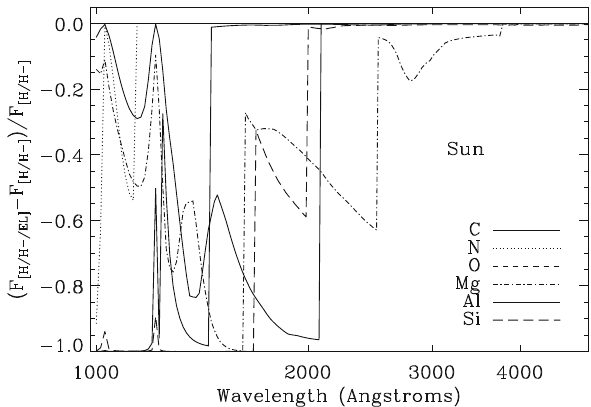
Fig.4 Impactofcontinuumopacityofdifferentatomsontheshapeofthesolarfluxrelativetothedominant source of continuum opacity, bound–free H and H − absorption. Image reproduced with permission